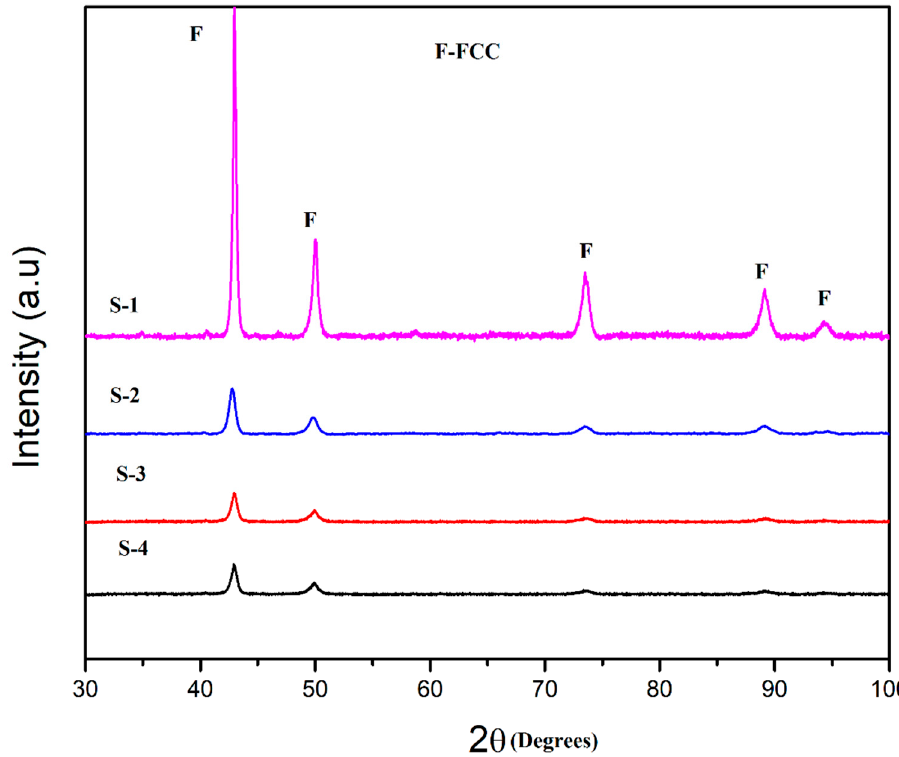
Figure 5. XRD patterns of as-sintered HEA NiMnFeCu at various sintering conditions.